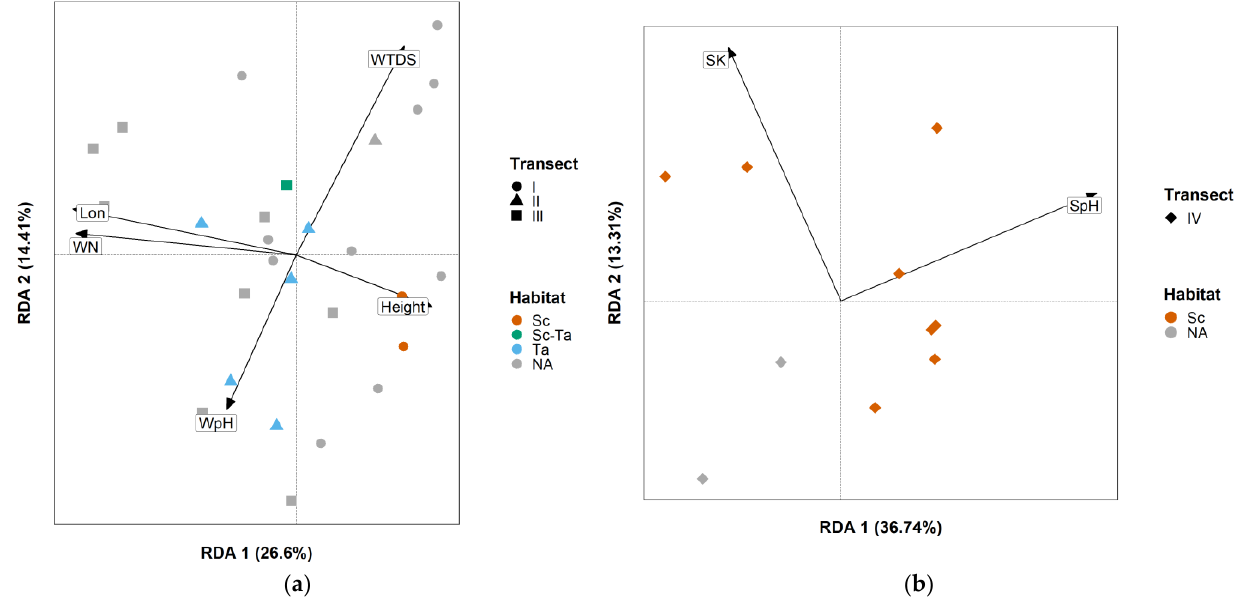
Figure 5. RDA ordination diagram for ( a ) Transect I/II/III and ( b ) Transect IV, linking Kalametiya Lagoon environmental variables and feeding guild composition among study sites. They use the two first ordination axes, RDA 1 and RDA 2, displayed on the left and bottom sides of each figure with their explained proportion in percentages. For habitat labels, cf. Table 1, except for NA, which is used for sites with no habitat affiliation. The shape of the dots displays transect affiliation: circle for Transect I, triangle for Transect II, square for Transect III, and diamond for Transect IV. Labels for environmental variables are: Lon = longitude, WN = water nitrate content, WTDS = water total dissolved solids, WpH = water pH, Height = mean tree height, SK = soil phosphate content, SpH = soil pH.